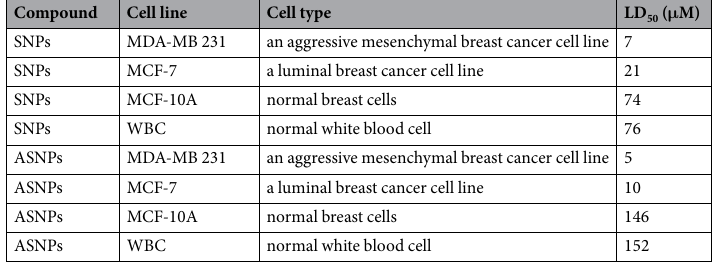
Table 2. LD 50 values of SNPs and ASNPs against MDA-MB 231, MCF-7, MCF-10A and